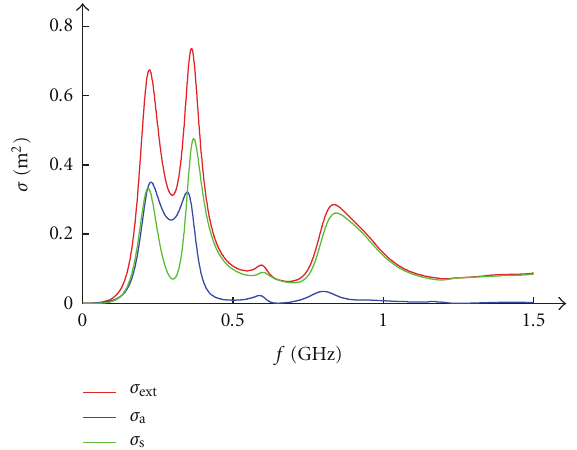
Figure 10: Extinction, absorption, and scattering cross sections of the array depicted in Figure